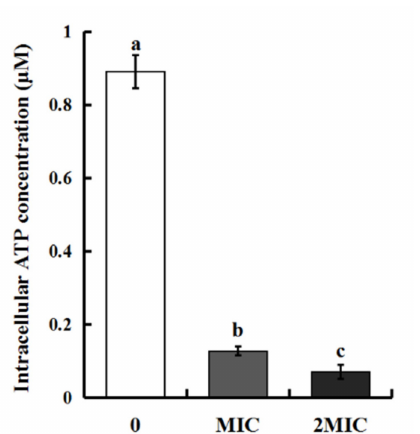
Figure 5. E ff ect of MEO on the intracellular ATP concentration of S. aureus. Di ff erence letters means statistical di ff